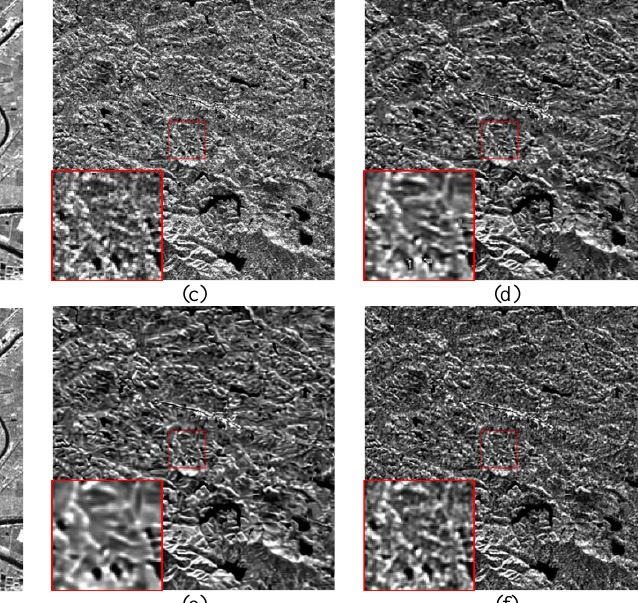
Fig. 5 Despeckled images for the Sentinel SLC image. (a) Noisy image. (b) UTA. (c) NLTF. (d) MSAR-BM3D. (e) RABASAR. (f) the proposed MSAR-CNN.